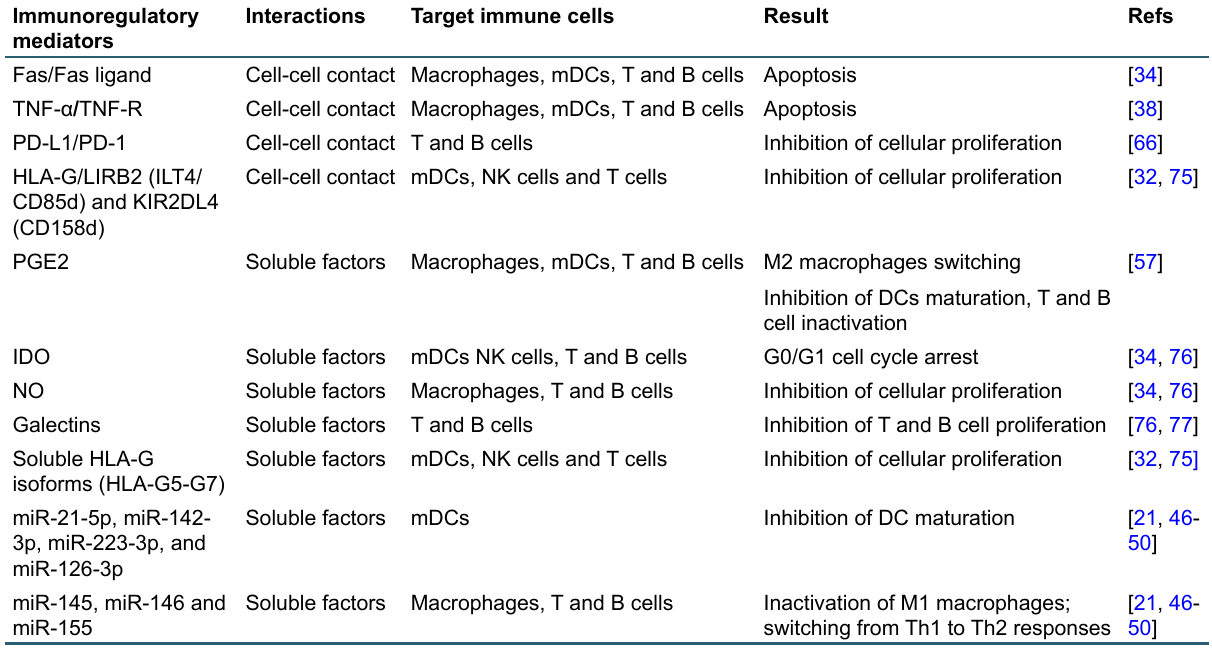
Table 1. Immunomodulation mechanisms of MSCs. MSCs modulate the immune responses of the target immune cells, using cell-cell interactions and the secretion of soluble